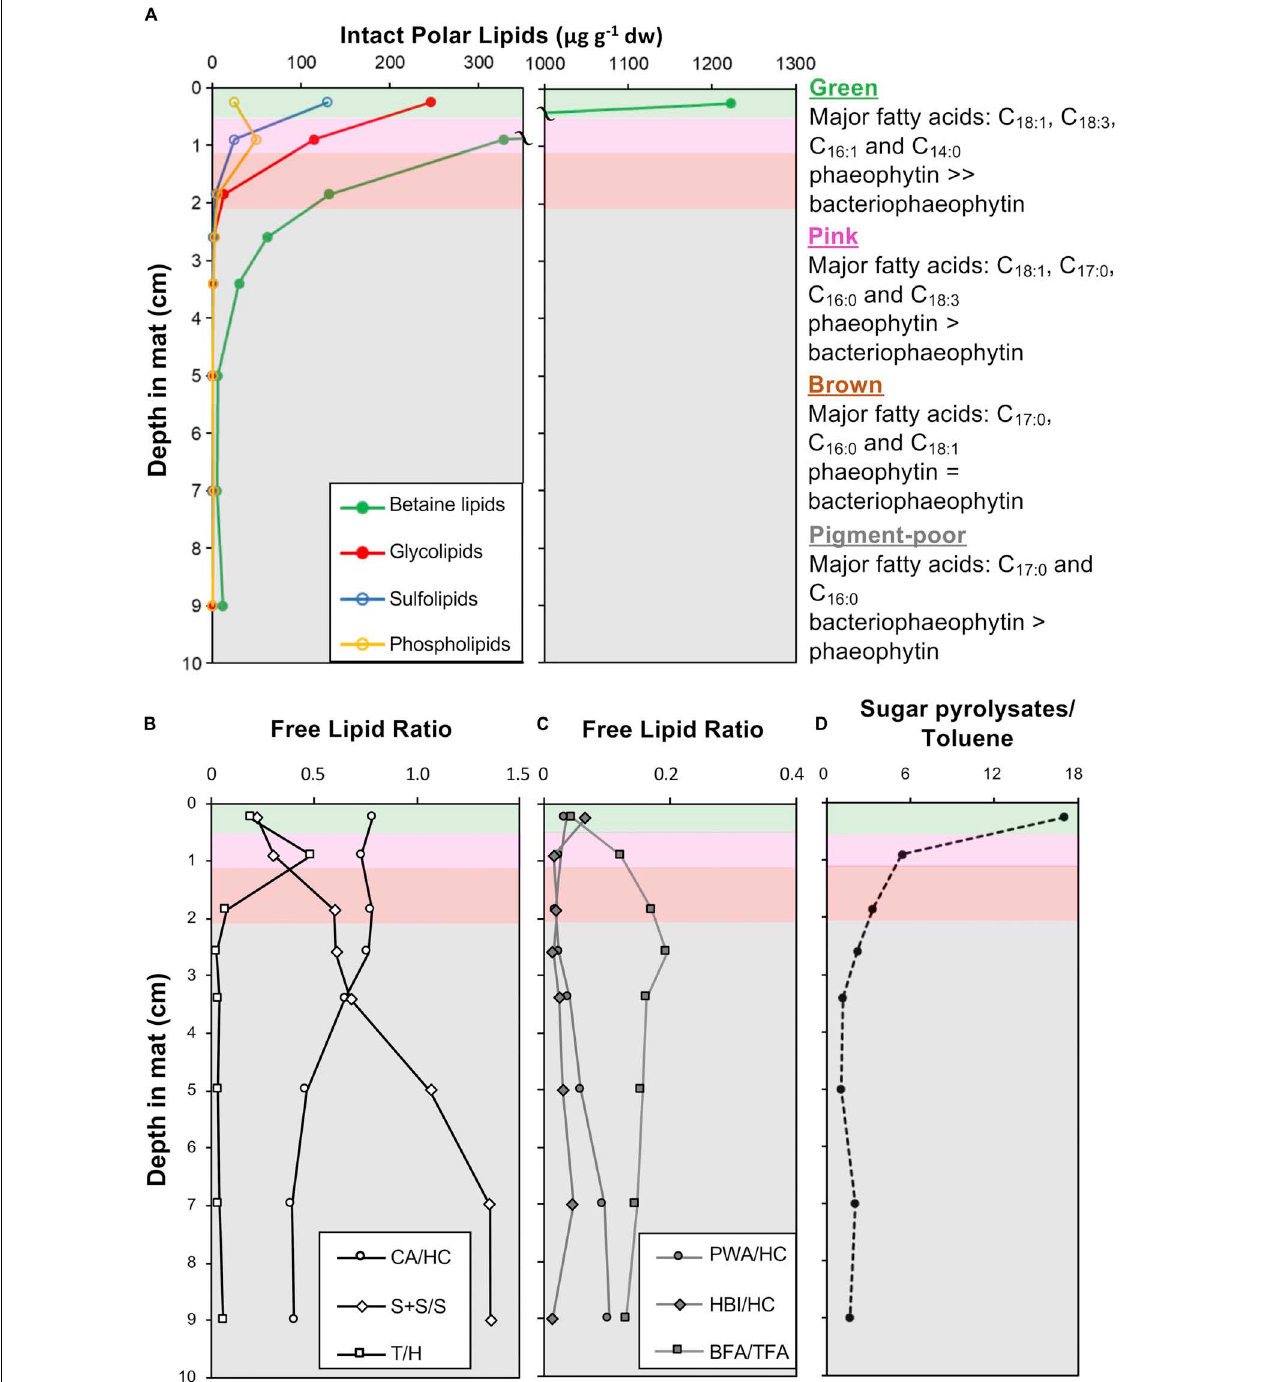
FIGURE 10 | Depth profiles in CC2 showing: (A) intact polar lipid (IPL) classes, (B) free lipid ratios with abbreviations: CA, cyanobacterial alkanes; HC, total hydrocarbons; S + S/S, stanols and steranes/stenols; T, taraxerol; and H, total hopanols (C) free lipid ratios with abbreviations: PWA, plant wax alkanes; HC, total hydrocarbons; HBIs, highly branched isoprenoids; BFA, bacterial fatty acids, and TFA, total fatty acids (D) the ratio of sugar to toluene pyrolysates in pigment-rich (green and pink) and pigment-poor (brown, olive-green, dark-green, and three underlying) layers. A summary of the major fatty acids bound in IPLs is given to the right of the plots and full dataset is provided in Supplementary Table S3 . The major unesterified, free lipid data and ratios are provided in Supplementary Table S4 . Pyrolysates detected are reported in Supplementary Table S5 . Total ion chromatograms and mass spectral information for identified lipids are provided in Supplementary Figures S3, S4